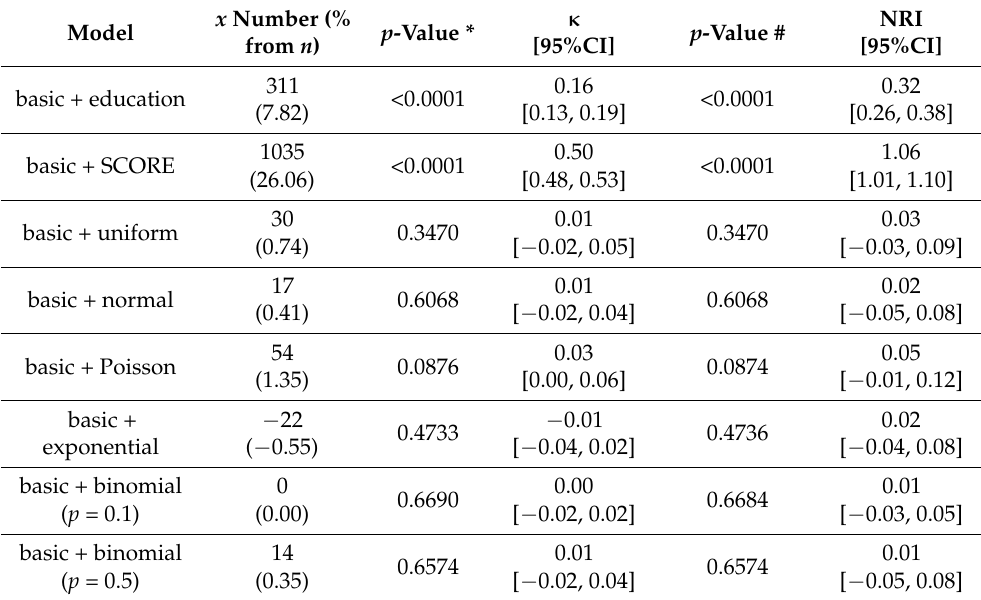
Table 6. Reclassification quality based on Cohen Kappa and Net Reclassification Improvement (NRI) for a continuous change of CVD risk between the base and extended logistic regression models. Model